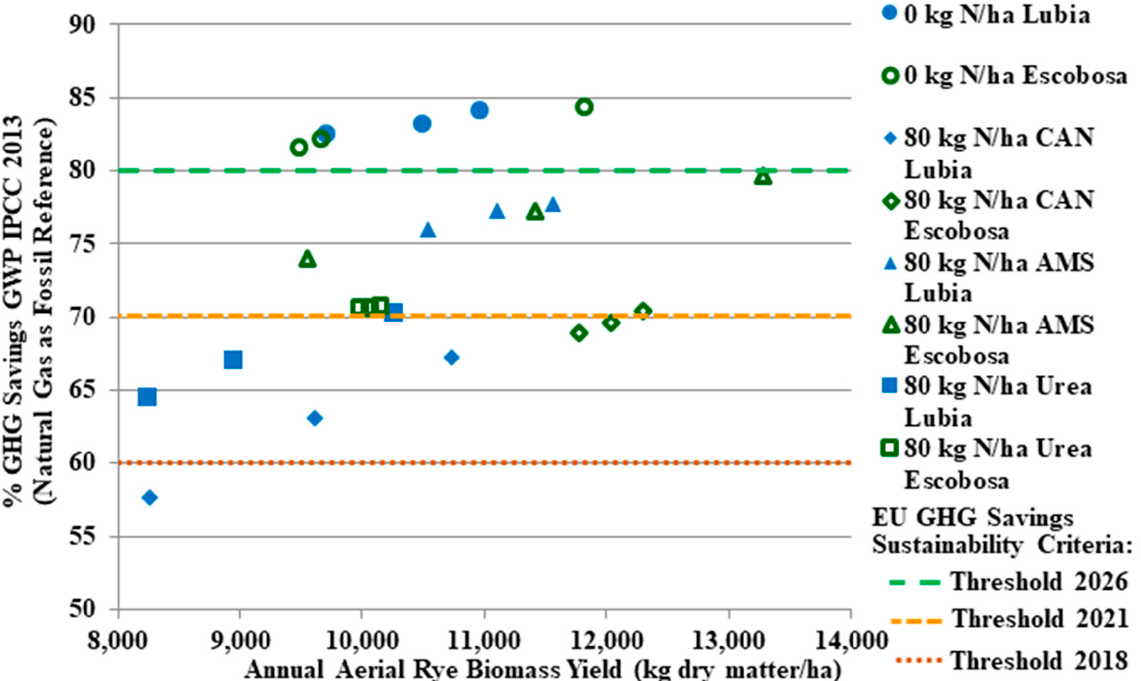
Figure 2. Relationship between the GHG savings obtained when producing bioenergy with rye energy crops grown under different fertilizer regimes with respect to natural gas and depending on the aerial biomass production (calculated with the GWP IPCC 2013 100 years method). GWP: Global warming potential, IPCC: Intergovernmental panel on climate change, CAN: calcium ammonium nitrate, AMS: ammonium sulphate, EU GHG: European Union greenhouse gases.